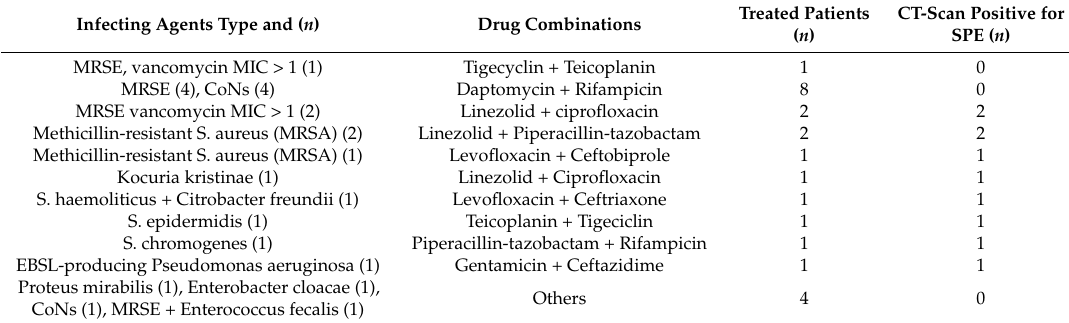
Table 2. Infecting agent, antibiotic therapy used, number of treated patients, and lung involvement of the 23 episodes of